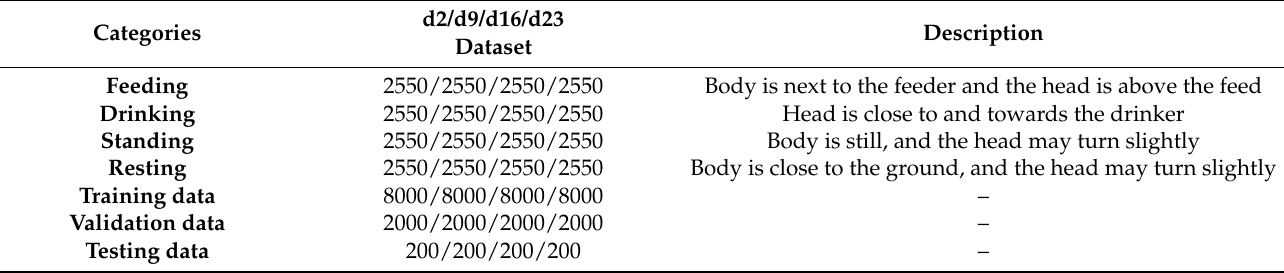
Table 1. Broiler behavior dataset information.